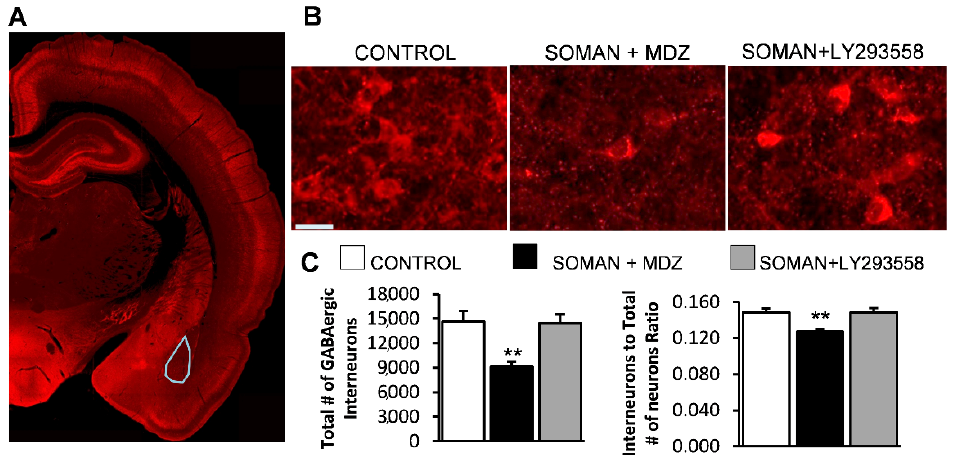
Figure 3. Thirty days after soman exposure, there was significant loss of GABAergic interneurons in the BLA of the MDZ-treated group but not the LY293558-treated group. ( A ) Panoramic view of a GAD-67 immuno-stained section showing the area where interneuronal loss was assessed; ( B ) Representative photomicrographs of GAD-67 immuno-stained interneurons in the BLA from a control (not exposed) rat and an MDZ- or LY293558-treated soman-exposed rat (total magnification 630 × ; scale bar, 50 µ m); ( C ) Group data of the total number of GABAergic interneurons (left panel) and the ratio of the number of GABAergic interneurons to the total number of neurons (right) for the two experimental groups and a control group. Sample sizes: n = 8 for each group; ** p < 0.01 compared with either the control or the SOMAN + LY293558 group (ANOVA, Bonferroni post hoc test).